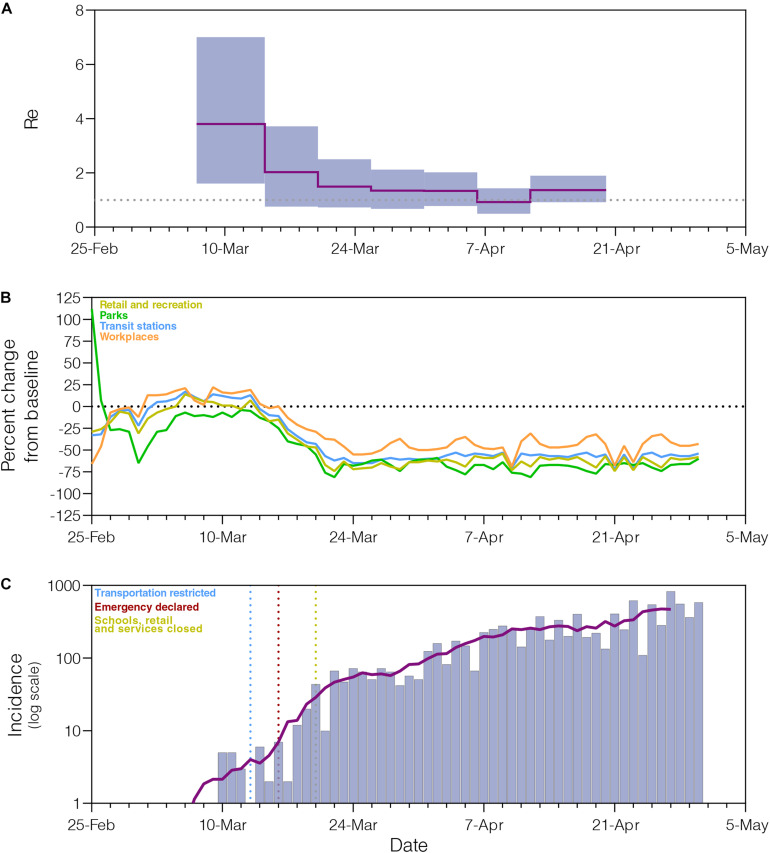
Epidemiological and mobility indicators of the SARS-CoV-2 epidemic in Rio de Janeiro. (A) Temporal variation of the effective reproductive number (Re) of the B.1.1.33 lineage in Rio de Janeiro estimated using the Bayesian birth–death approach. (B) Mobility data trends reported as percentage change measured against baseline. Each parameter is colored following the legend. (C) Progress of incidence of SARS-CoV-2 in Rio de Janeiro. The line represents the weekly average. The date of the main epidemic control measures is indicated by the vertical dotted lines.